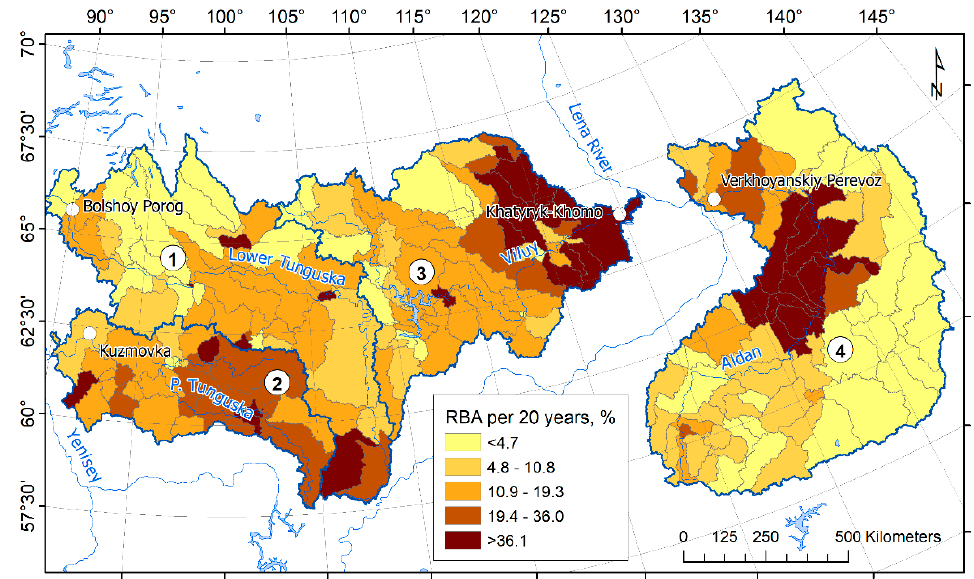
Figure 1. The study area and river basins. The color gradient corresponds to the relative burned area per 20 years of satellite monitoring. The river basins are: 1—Lower Tunguska, 2—Podkamennaya Tunguska, 3—Viluy, and 4—Aldan.